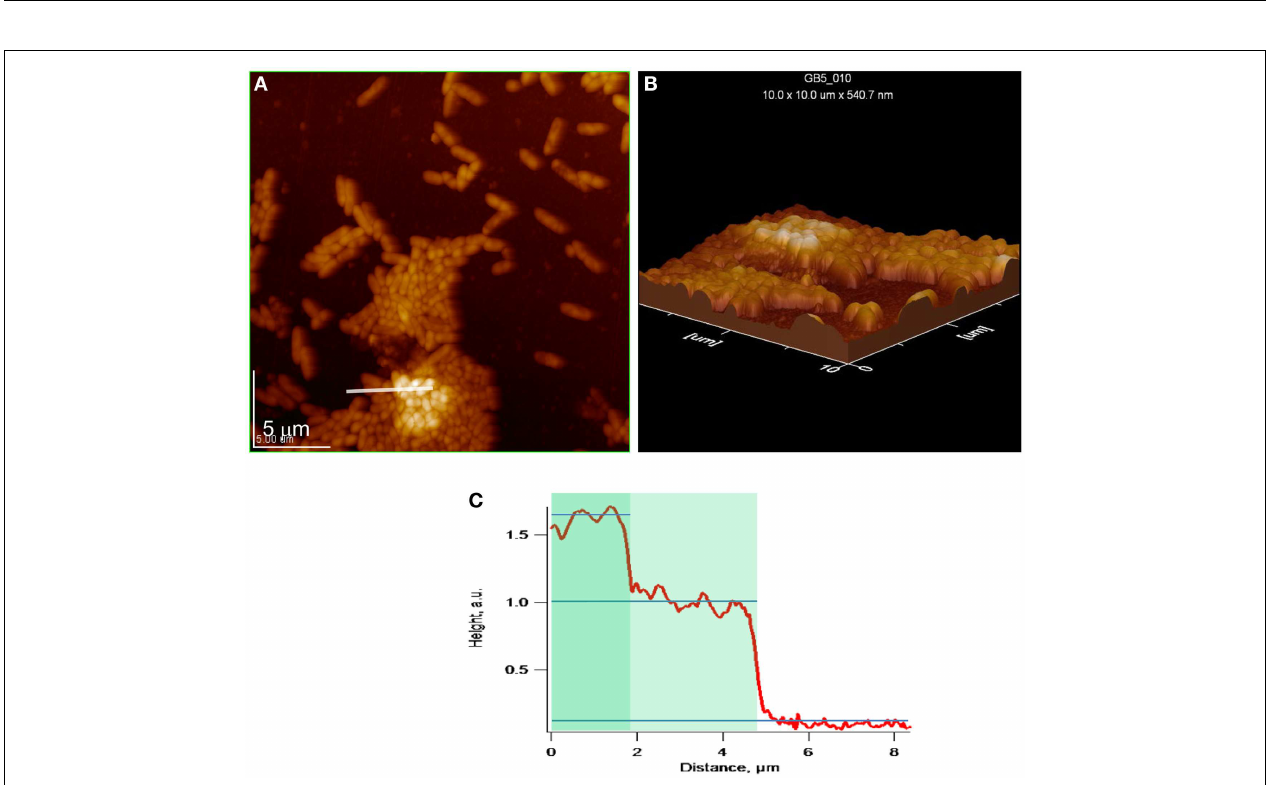
FIGURE 7 | Exponential phase biofilm . (A,B) Topographical and 3D AFM images of cell cluster.White line indicates location of topographical profile, (C) topographical profile that includes bare gold and one- and two-cell thick regions of a cell cluster.